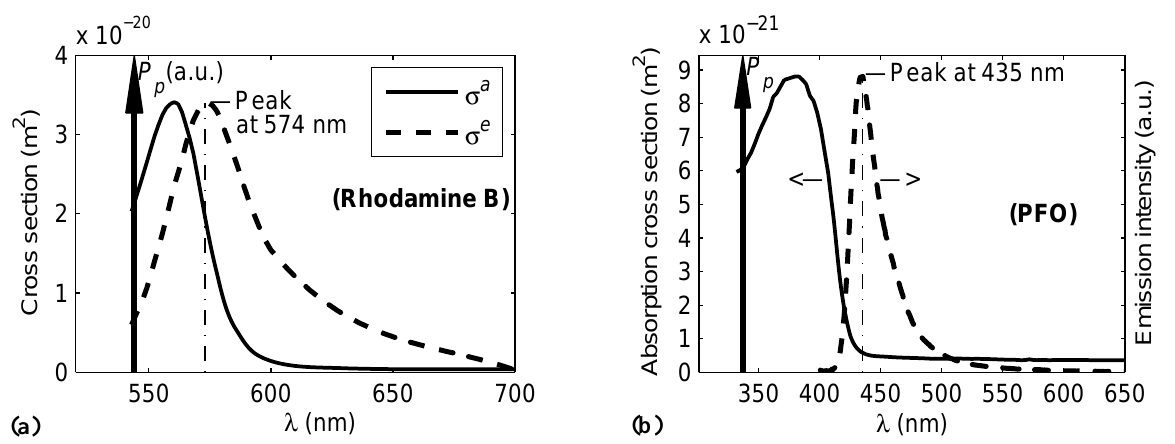
Figure 3. Emission (dashed line) and absorption (solid line) spectra of ( a ) rhodamine B (RB) and ( b ) poly(9,9-dioctylfluorene) (PFO) embedded in poly(methyl-methacrylate) (PMMA). The vertical arrow indicates the typical spectral location of the pump power P in each